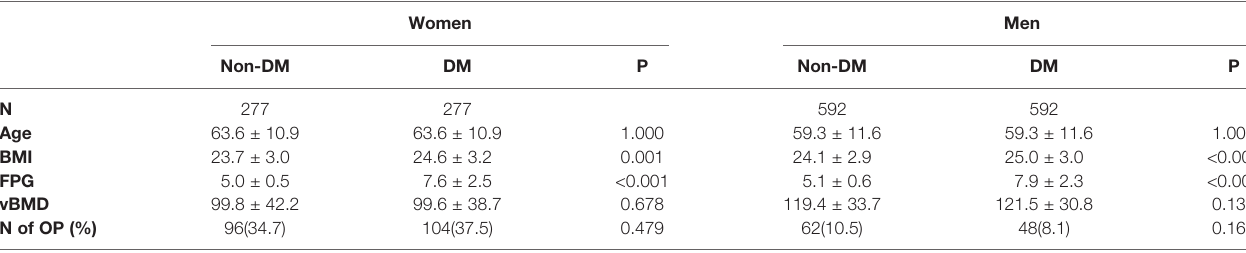
TABLE 3 | Characteristics of matched participants with and without DM using propensity score in the QCT full cohort.